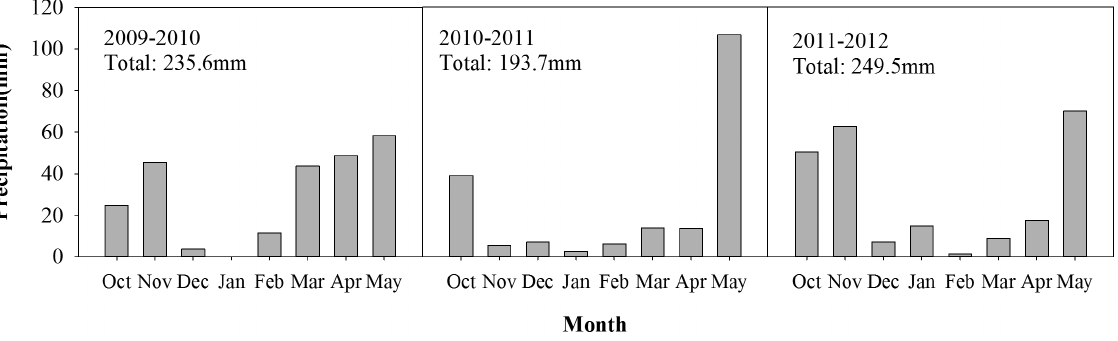
Figure 1. Monthly and total precipitation during the 2009–2012 wheat growing seasons. Monthly precipitation of wheat growing seasons in 2009–2010, 2010–2011, 2011–2012 in Shaanxi,